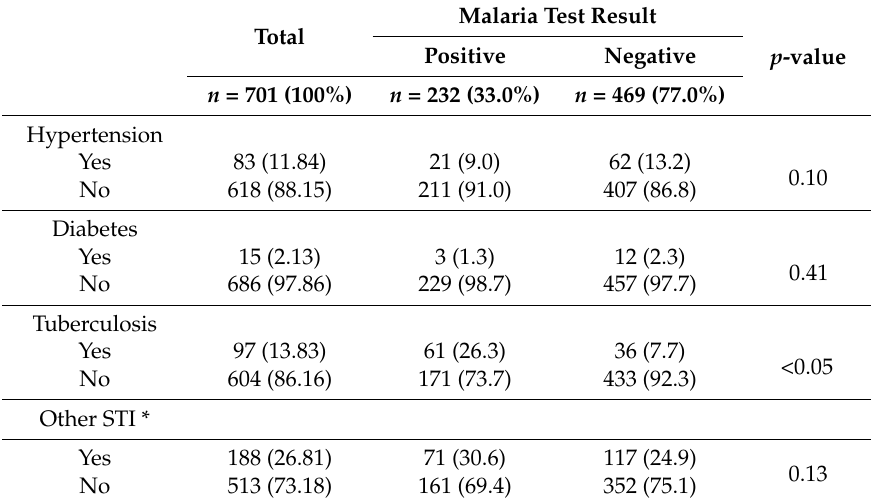
Table 2. Distribution of co-morbidities among the 701 HIV positive patients enrolled, stratified by Malaria test